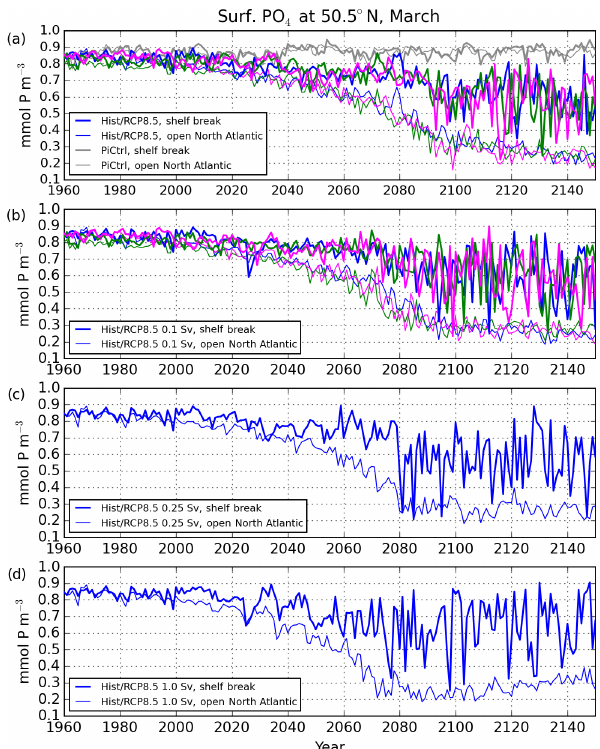
Figure A5. Pre-bloom (March) surface phosphate concentration at the Celtic shelf break (50.5 ◦ N, 10–12 ◦ W, thick lines) and in the open NE Atlantic (50.5 ◦ N, 15–20 ◦ W, thin lines) for the control run C0 (gray) and individual realizations (blue, green, magenta) of experiments E0 (a) , E010 (b) , E025 (c) and E100 (d) .